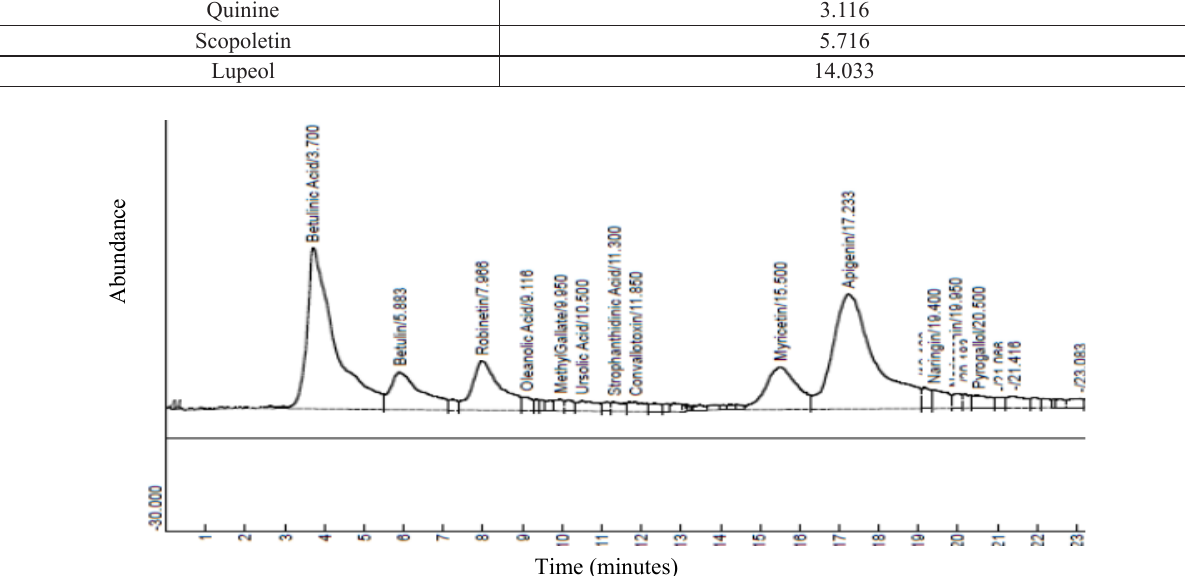
Fig. 4. Chromatogram of phytochemicals in fractionated extract Entada